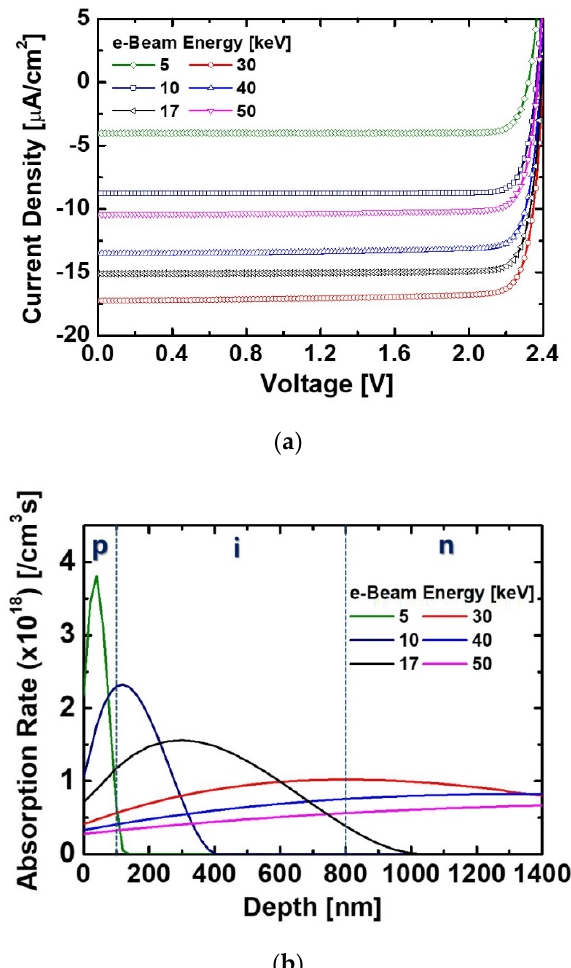
Figure 7. ( a ) Current characteristics of the diodes irradiated by different e-beam energies and ( b ) absorption rate varied by different e-beam energies. All devices were designed with a H p-GaN of 100 nm and H i-GaN of 700 nm. The D p-GaN and D n-GaN of the devices were 5 × 10 17 cm −3 and 5 × 10 18 cm −3 , respectively.